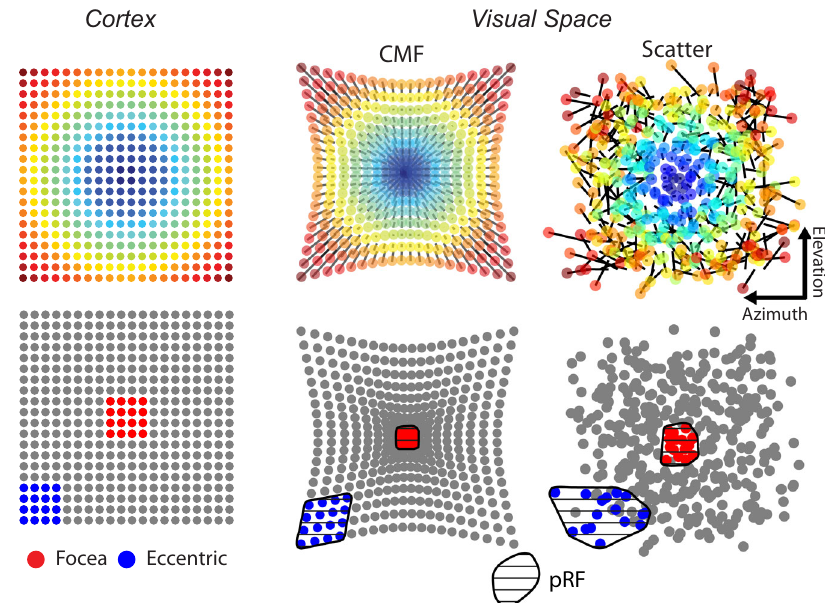
Fig. 3 Conceptual models of pRF size. Upper row: two conceptual models of V1 that could account for the in fl uence of r-eccentricity on pRF size in the wide- fi eld data. The top left panel shows the position of model cell bodies in V1. The other panels show models in which RF positions are displaced purely by changes in cortical magni fi cation factor (CMF), with lower magni fi cation at higher eccentricities (middle) or by increased RF scatter at larger eccentricities (right). The black lines connected to each RF illustrate the displacement of the RF. Lower row: two equally sized analysis windows were drawn on the cortex, one at the foceal representation (red) and one in the periphery (blue). The RFs of cells within the analysis window are shown colored in the right panels. An estimate of the pRF can be made by taking the convex hull (shaded region) of the RF positions in space. Both the CMF and scattering model result in smaller pRFs at the focea (compare the areas of the red and blue